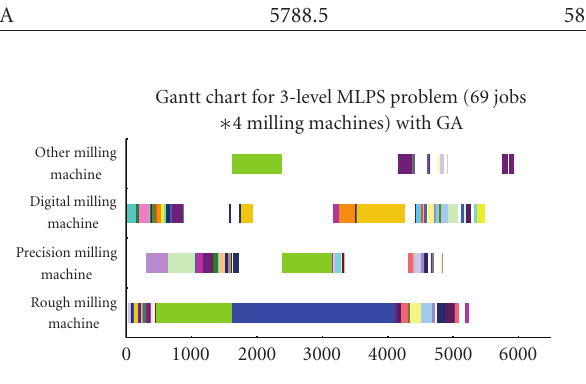
Figure 12: A typical solution of 3-level MLPS with